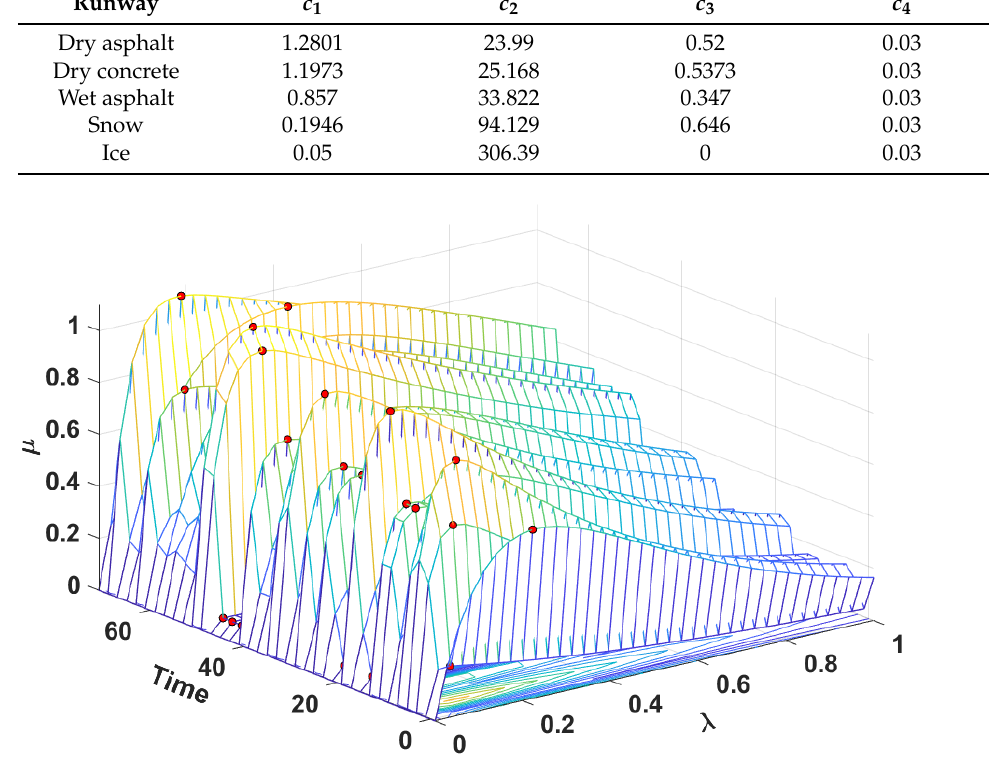
Figure 8. Different kinds of runway given by